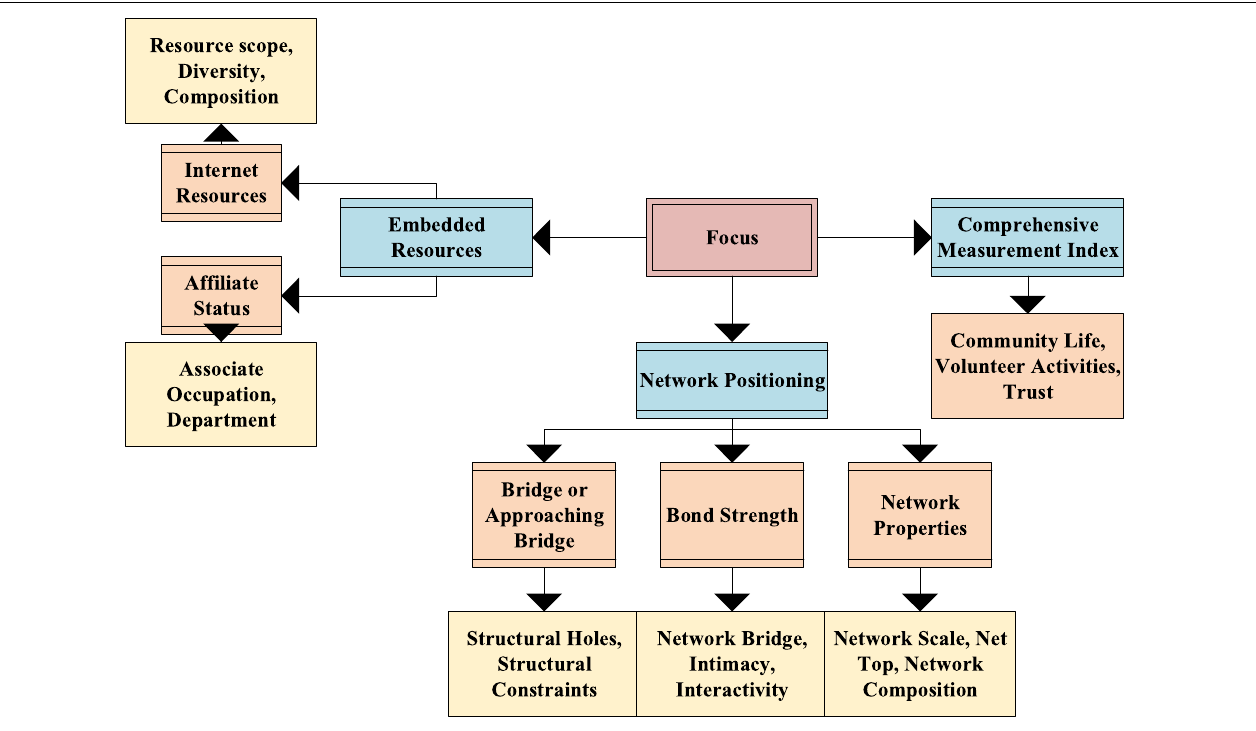
FIGURE 1 | Social entrepreneurship capital test